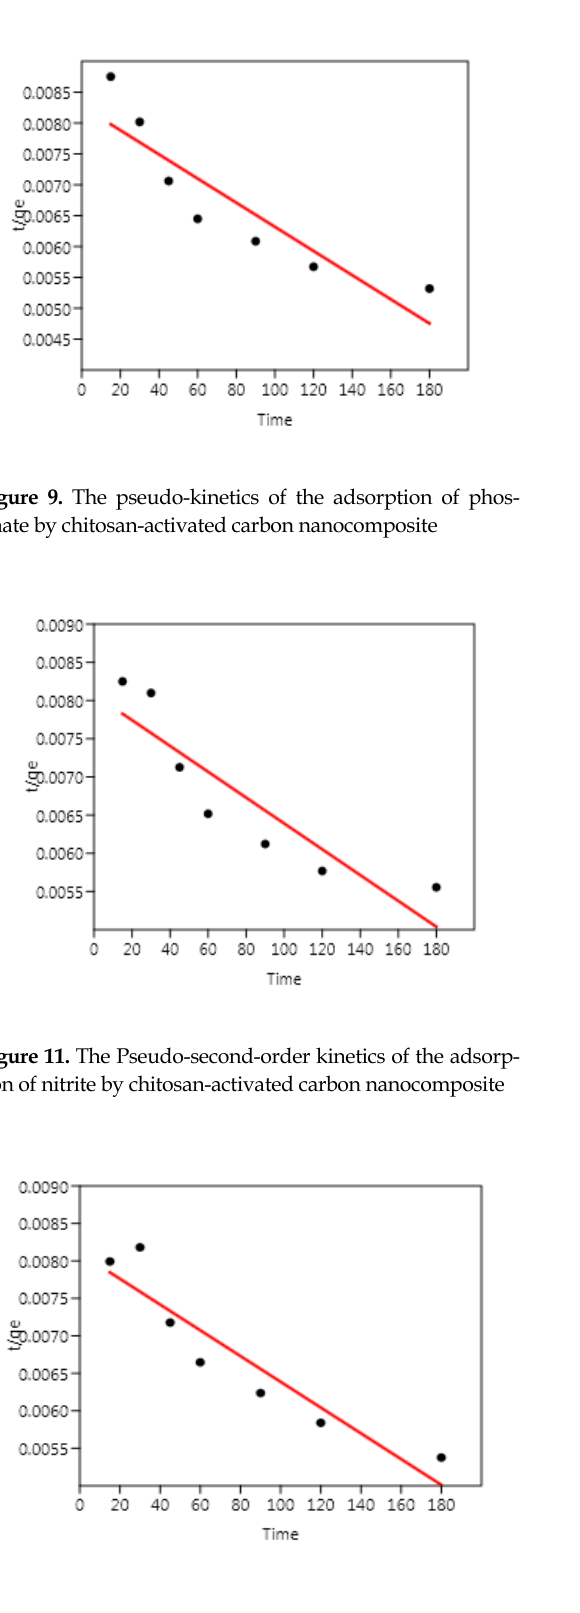
Figure 13. The pseudo-second-order kinetics of ammonia adsorption by chitosan-activated carbon nanocomposite